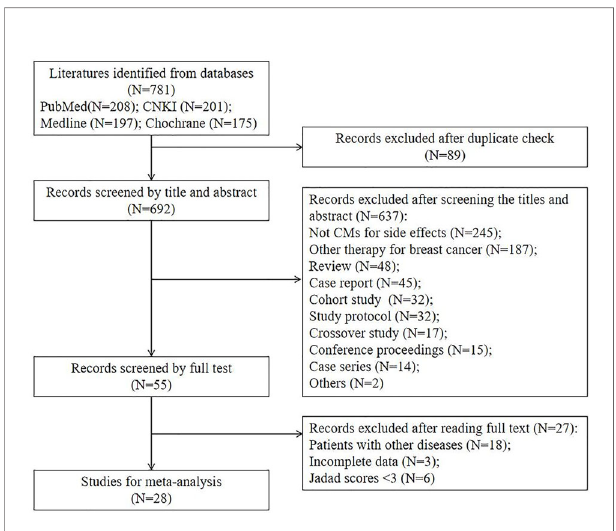
FIGURE 1 | Study inclusion and exclusion fl ow